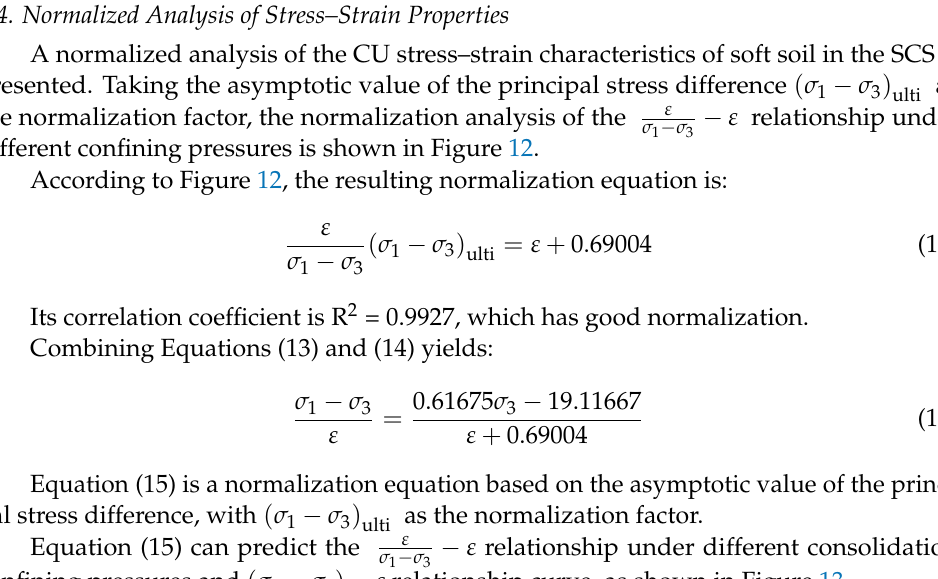
− σ 1 3 ) ulti and σ 3